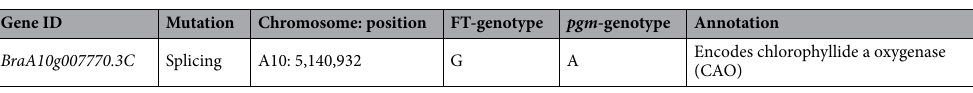
Table 4. Single nucleotide polymorphism (SNP) in the candidate region between wild-type (FT) and pale green mutant ( pgm